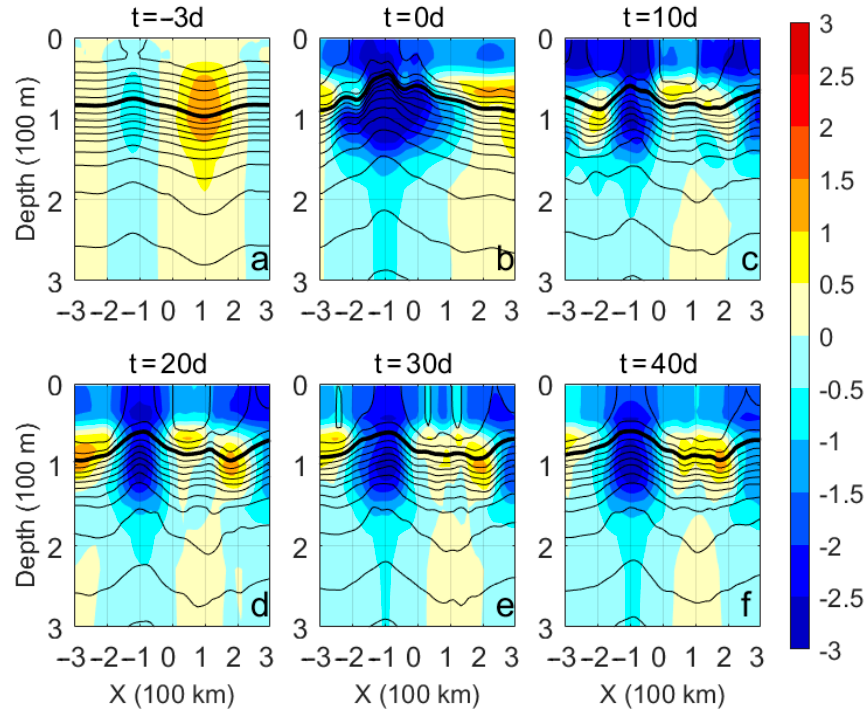
Figure 5. Vertical sections of thermal structure across the simulated dipole before and after the TC in the model: ( a – f ) are simulated sectional temperature anomalies (unit: °C) at − 3, 0, 10, 20, 30, and 40 days after the TC, respectively. The sections transect the COE and AOE at their centers. Colored shading represents the temperature anomaly. Contours represent the isotherms with a contour interval of 1 °C, where contours in bold represent the 20 °C isotherm.